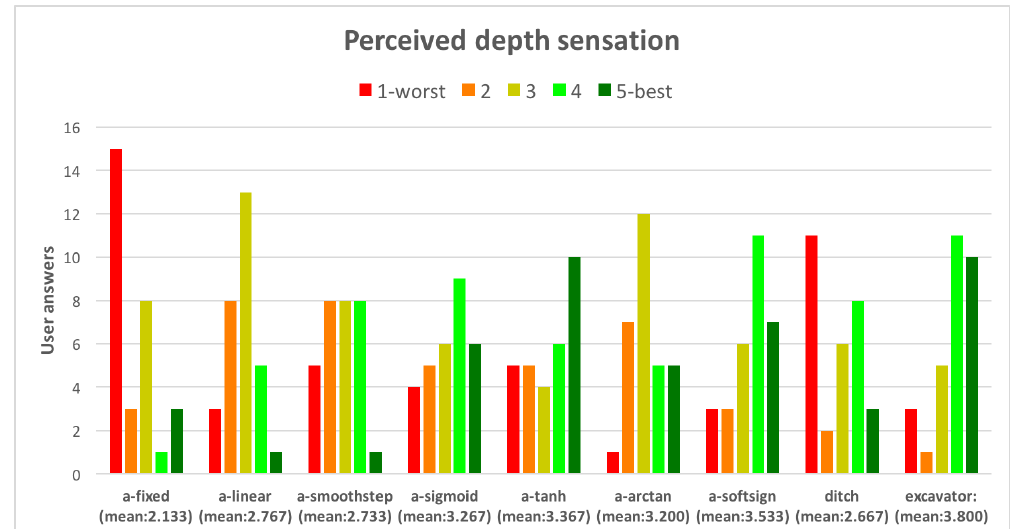
Figure 15. Answers of the survey participants per method.